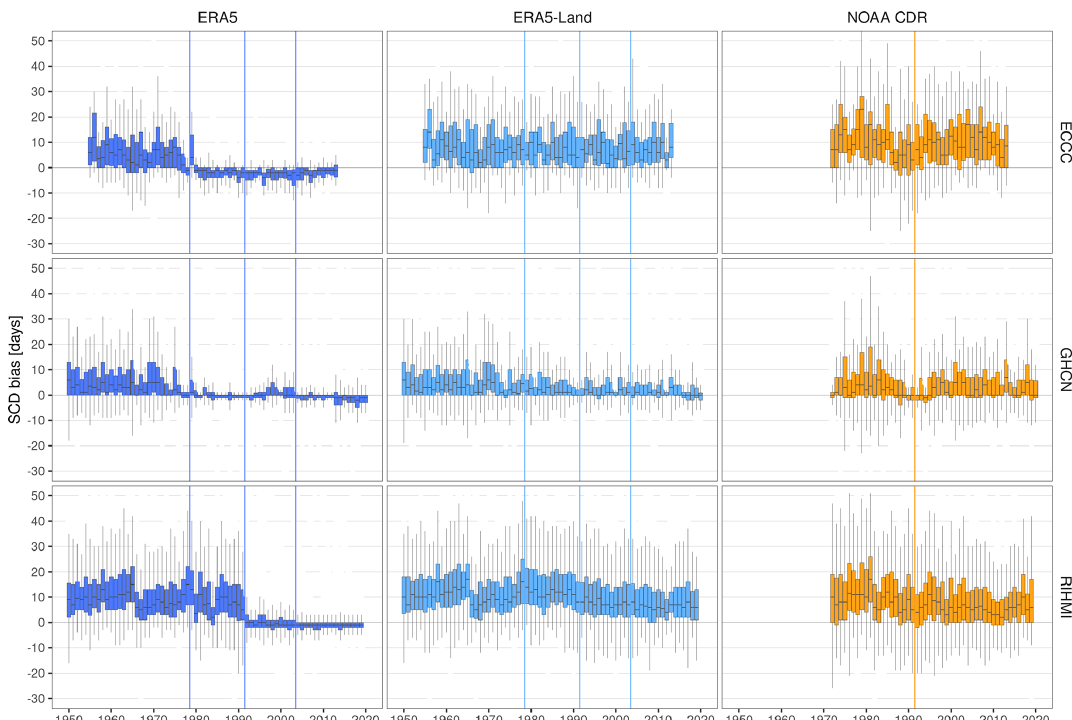
Figure A8. Temporal stability of the bias (product – station) in snow cover duration (SCD) per product and network during MAM. Vertical lines show the years when the potential discontinuities/trends in each product